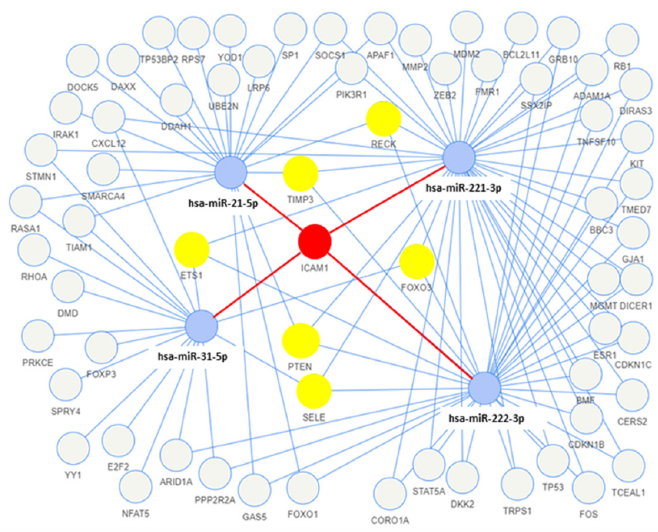
Figure 4. Network of the miRNA–target interactions using miRTarBase, with strong experimental evidence (e.g., luciferase assay, Western blotting). Blue circles are miRNAs, yellow circles are the target genes of three miRNAs, and the red circle is the target gene of four miRNAs.